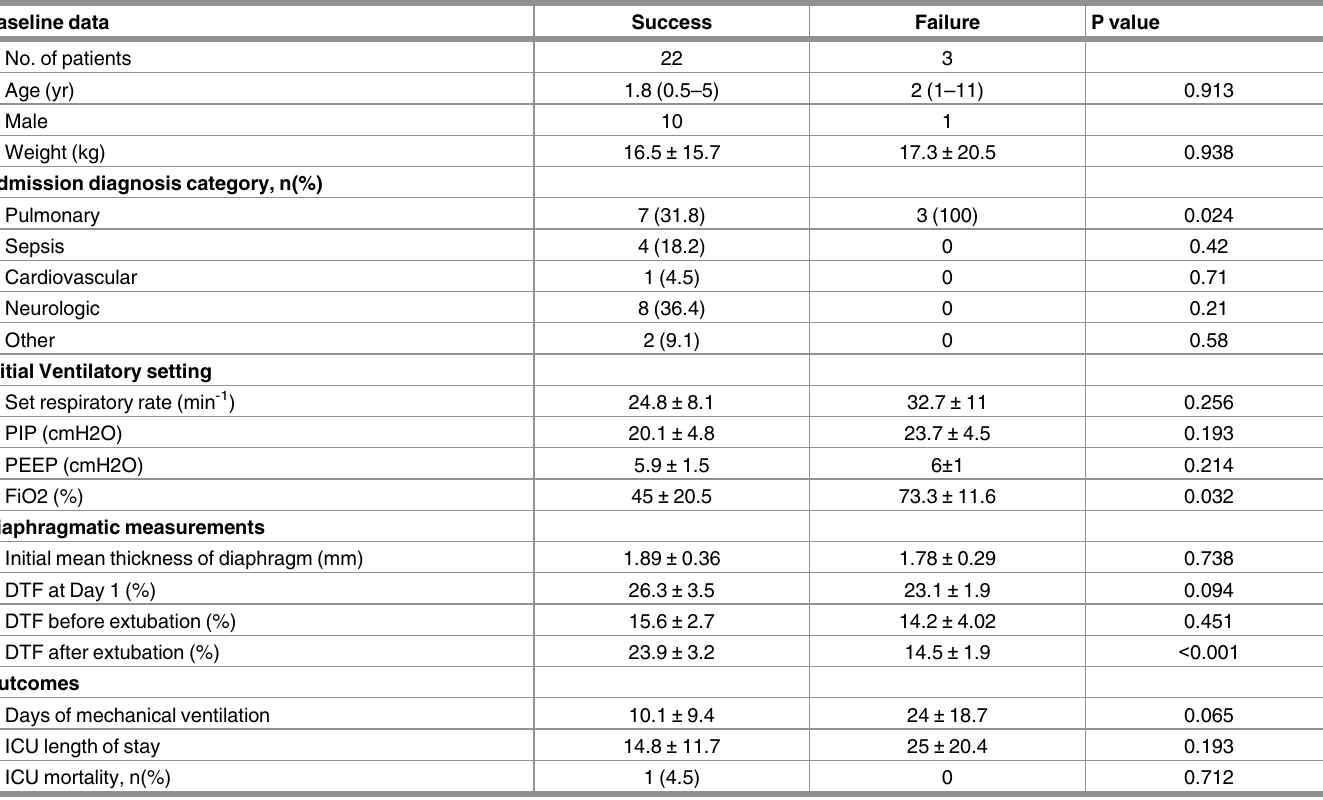
Table 3. Characteristics of successfuland failed extubation